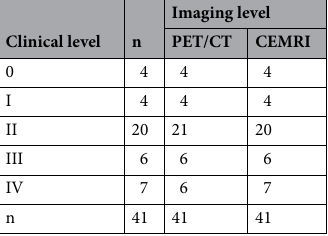
Table 1. Relationship between VTT level on PET/CT and CEMRI and clinical stage. CEMRI contrast- enhanced magnetic resonance imaging, PET/CT positron emission tomography/computed tomography.